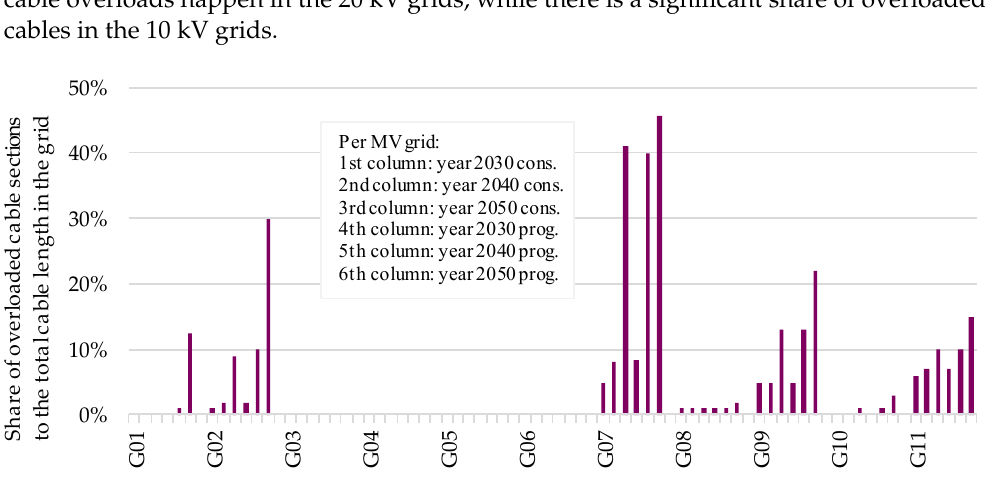
Figure 20. Share of the length of overloaded cable sections to the total cable length in the grid for the two development scenarios over three years until 2050 based on [59].